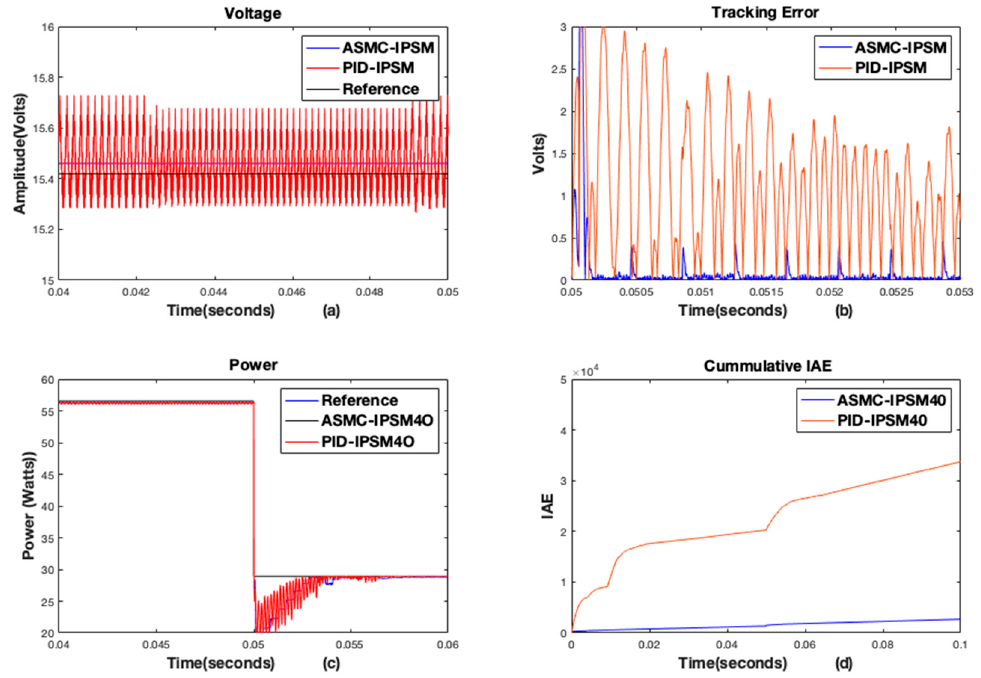
Figure 11. PID & ASMC based in IPSM. MPPT with 40 particles ( a ) Profile of the PV panel voltage ( b ) Tracking response ( c ) Profile of the PV power extraction ( d ) IAE.